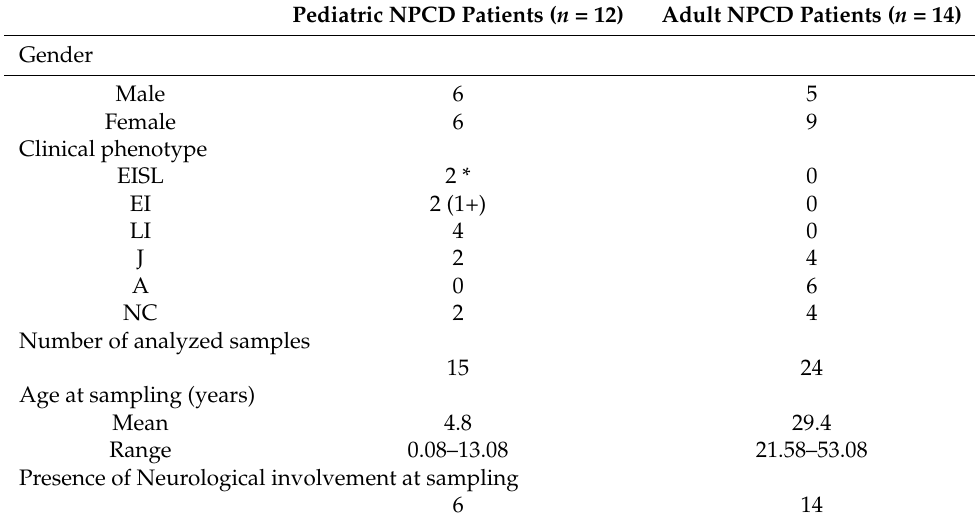
Table 1. Characteristics of the studied cohort.